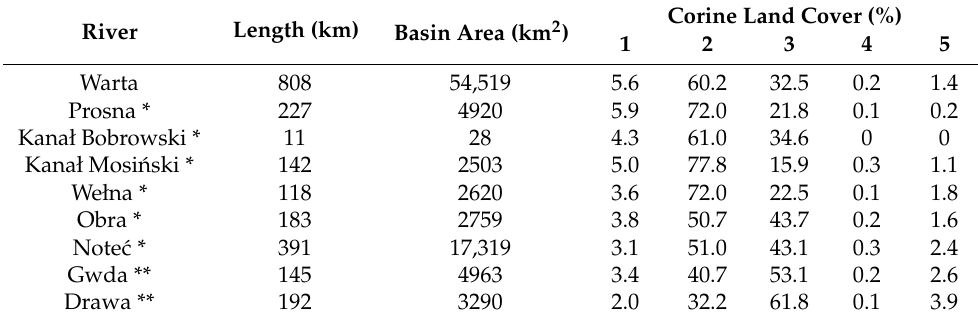
Table 1. Analysed rivers’ descriptions.